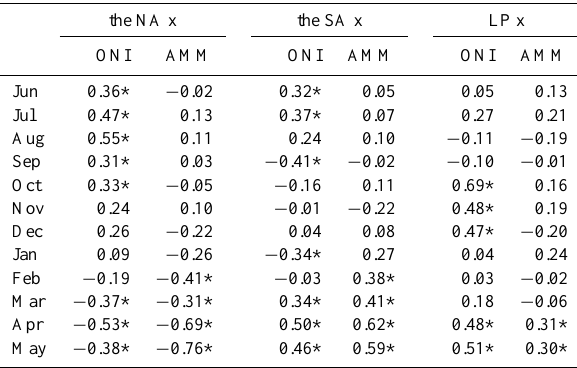
Table 1. Correlation coefficients between the monthly time series of ONI (and AMM) and: values of 10-day (E − P) backward tra- jectories from the Amazon Basin integrated over the NA and the SA source regions; of absolute values of 10-day (E − P) forward trajec- tories from the Amazon Basin integrated over the LP sink area. All time series cover a 33-year period. Values statistically significant at the 90% level according to a t -test are denoted